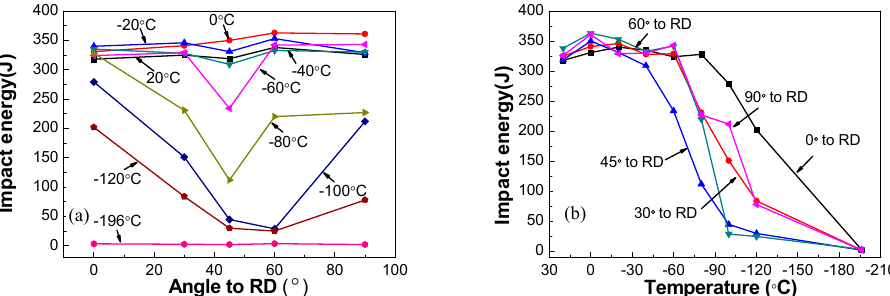
Figure 6. Charpy impact test result: ( a ) curve between impact energy and directions, ( b ) curve between impact energy and temperature.